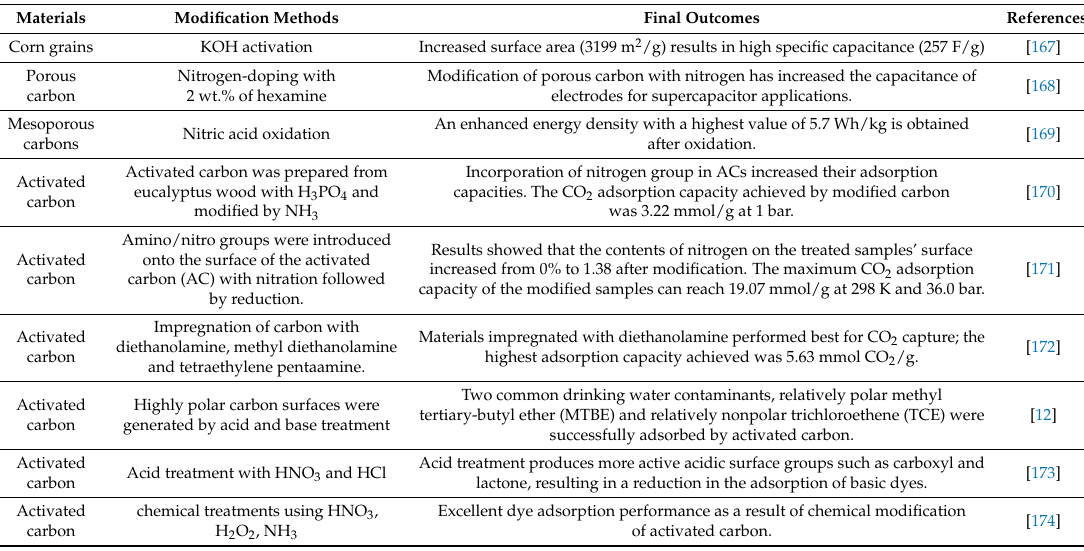
Table 7. Chemical modification of activated carbons and their